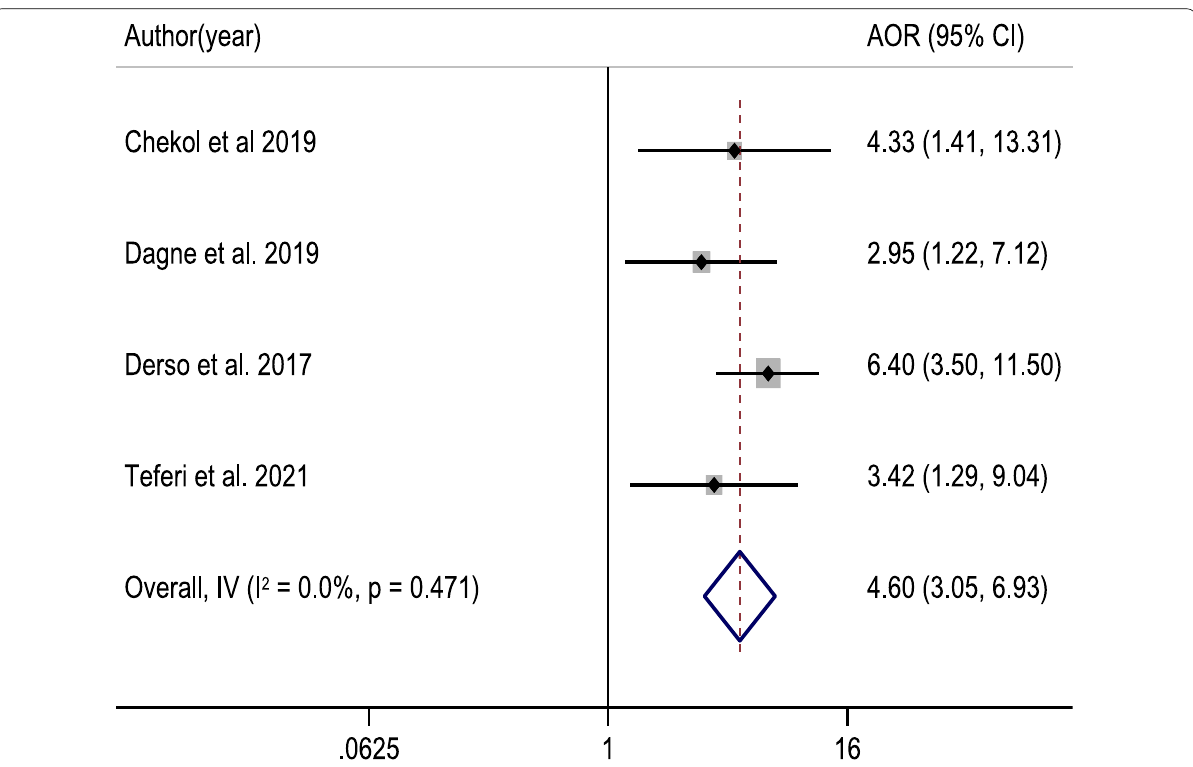
Fig. 9 The pooled adjusted odds ratio of the association between educational status of food handlers and food hygiene practice in